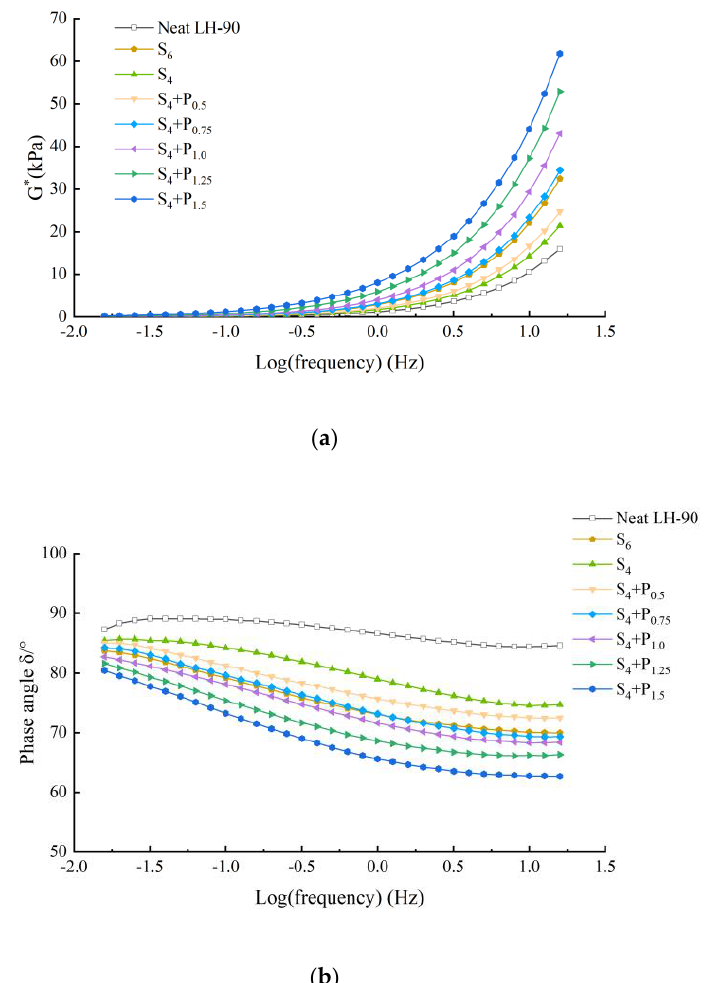
Figure 6. Complex modulus and phase angle master of compound PPA–SBS modified binders of LH– 90# asphalt: ( a ) Complex modulus-Log(frequency) results; ( b ) Phase angle-Log(frequency) results.